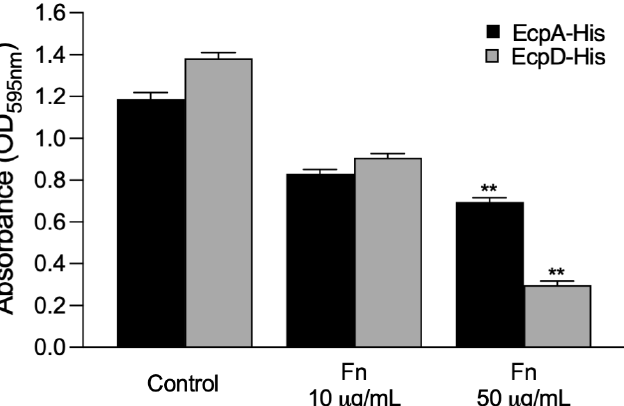
Figure 7. Soluble Fn inhibits binding of EcpA and EcpD to Fn. Biotinylated EcpA and EcpD proteins were incubated with 10 or 50 mg/mL of soluble Fn. The mix was then added to 96-well plates containing immobilized Fn. Binding of biotinylated proteins was detected with a streptavidin–peroxidase conjugate. BSA was used as a negative control. Data are the mean of three experiments performed in triplicate (Kruskal–Wallis test, ** p < 0.01).